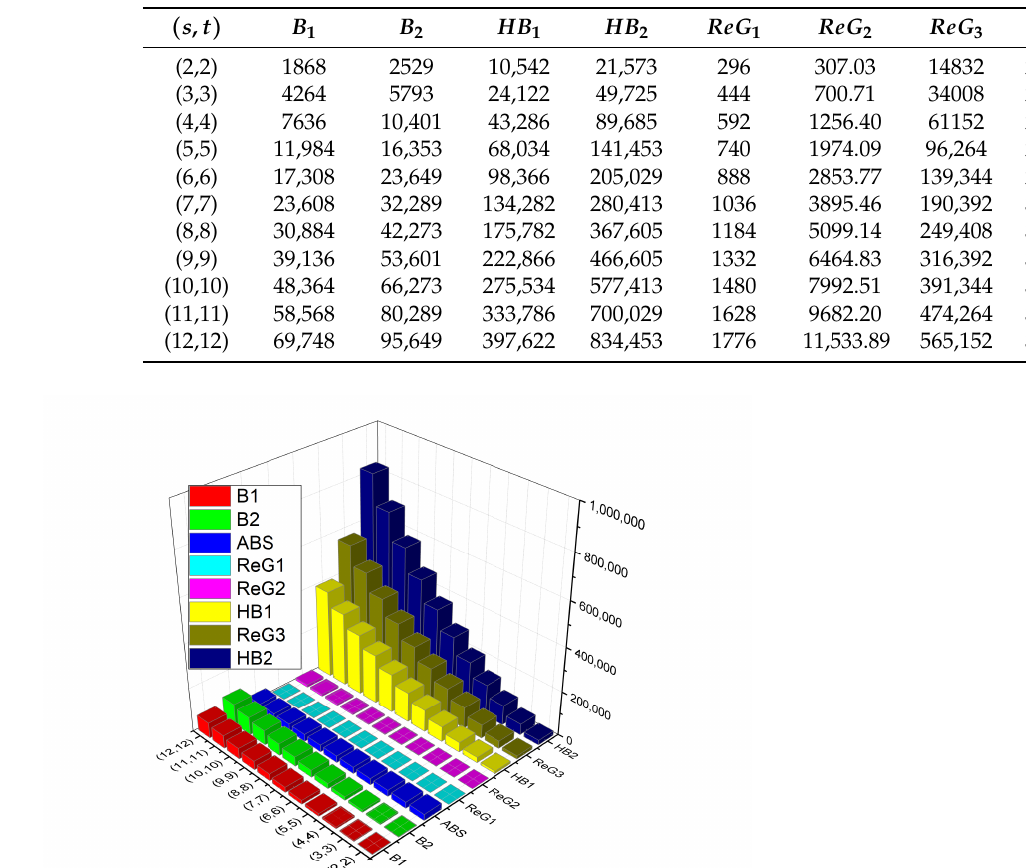
Figure 4. Graphical comparison of TI’s of metal–organic